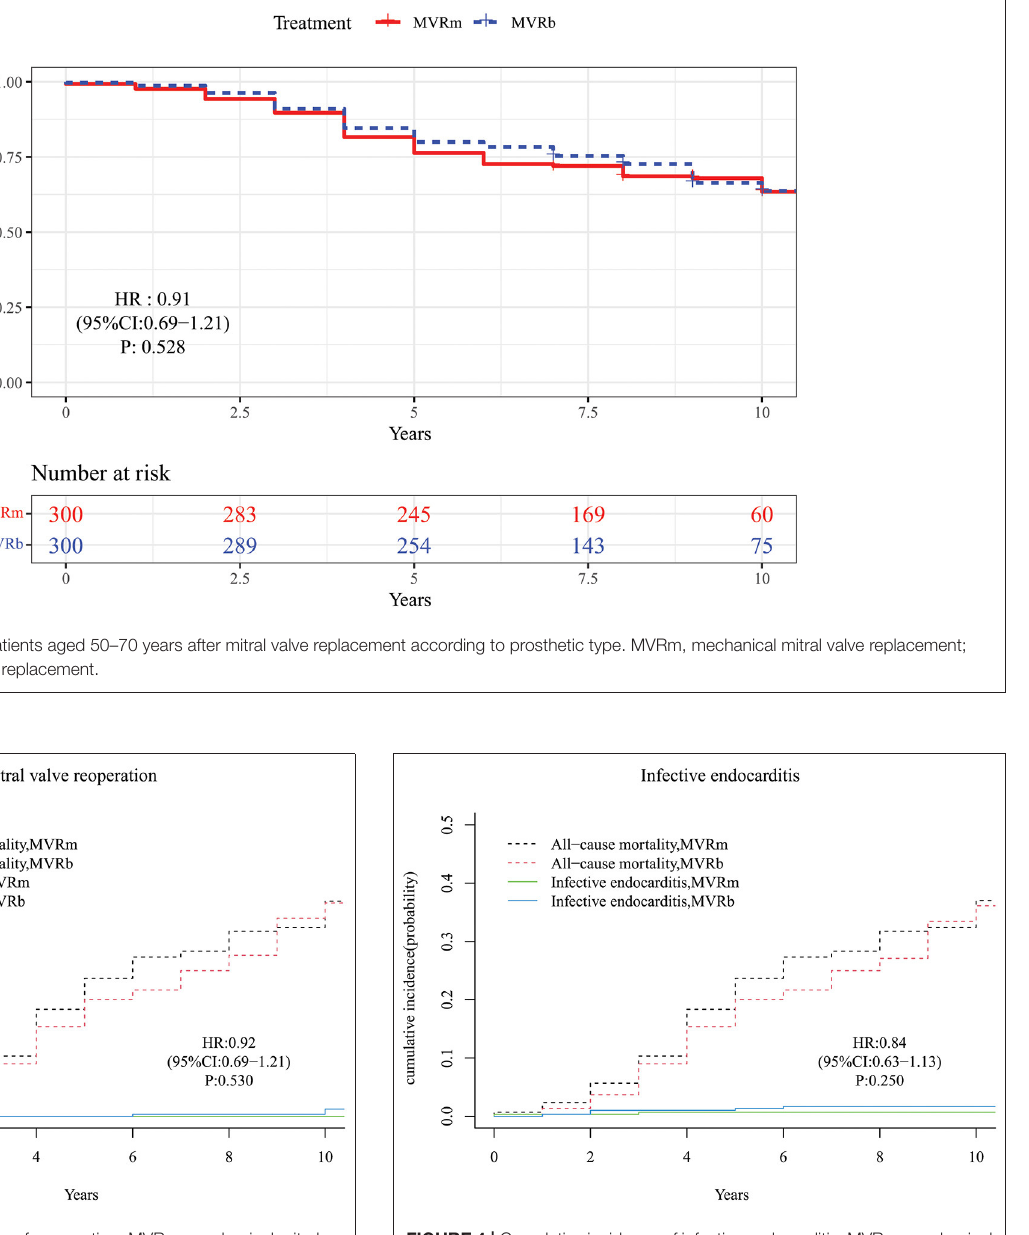
2.0, and 3.1% in the MVRm, and 1.3, 2.3, 4.4, and 6.7% in